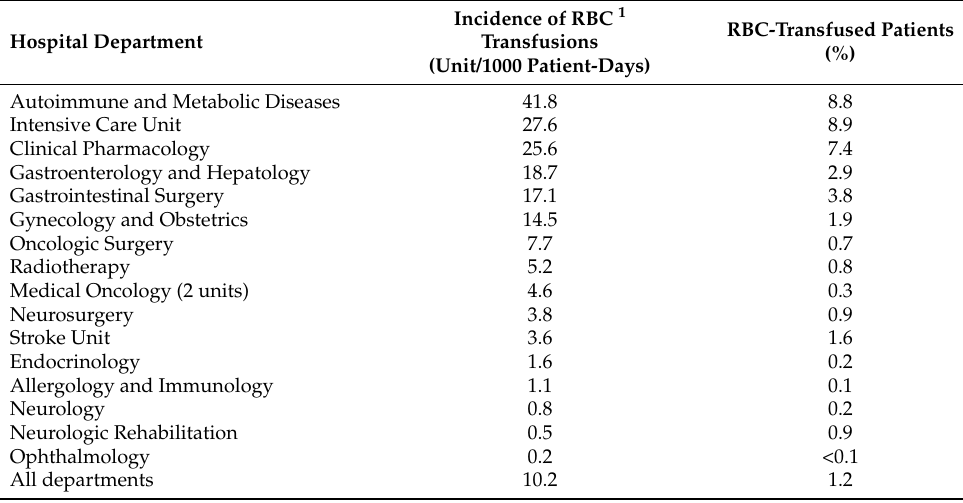
Incidence of RBC 1 RBC-Transfused Patients Transfusions (%) (Unit/1000 Patient-Days)